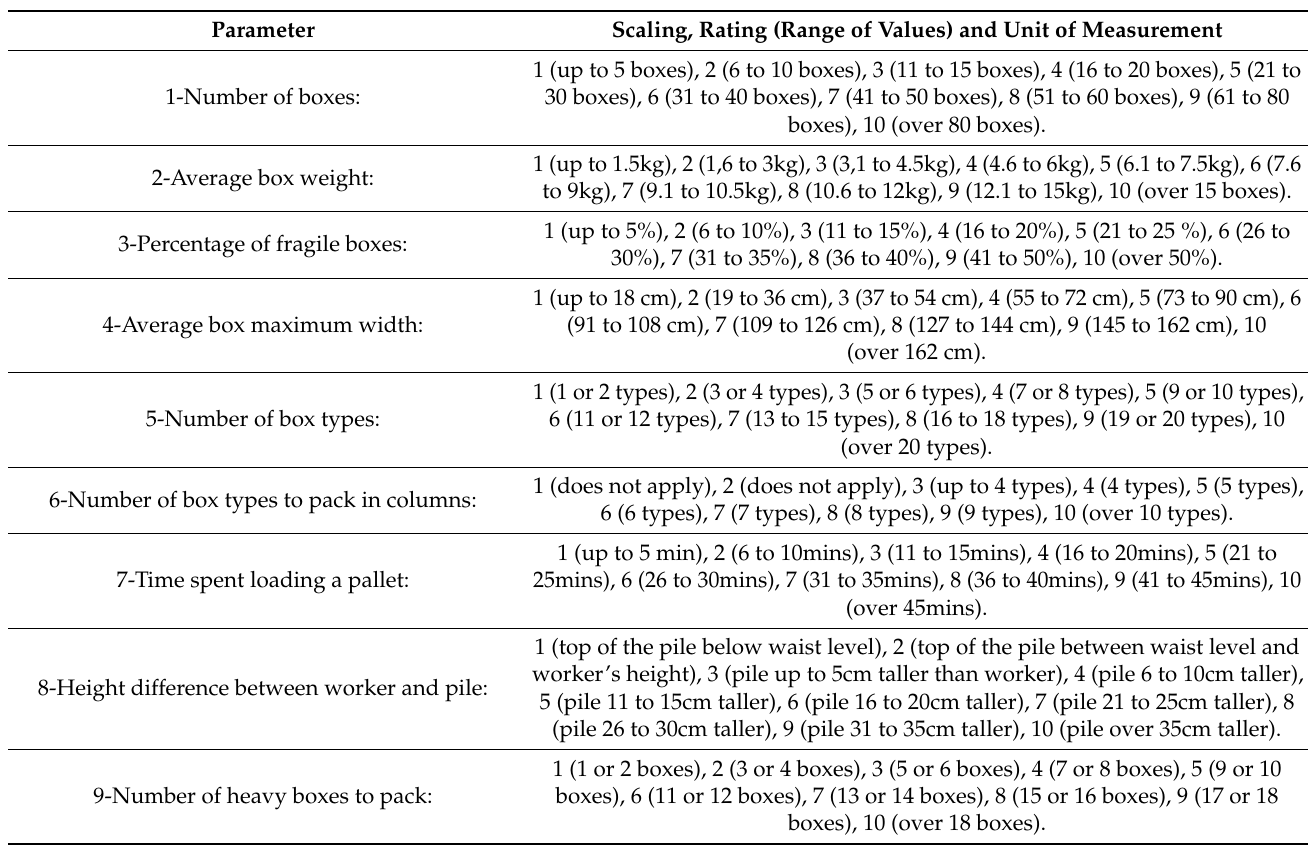
Table 1. Parameters and respective scaling, rating (range of values) and units. Parameter Scaling, Rating (Range of Values) and Unit of